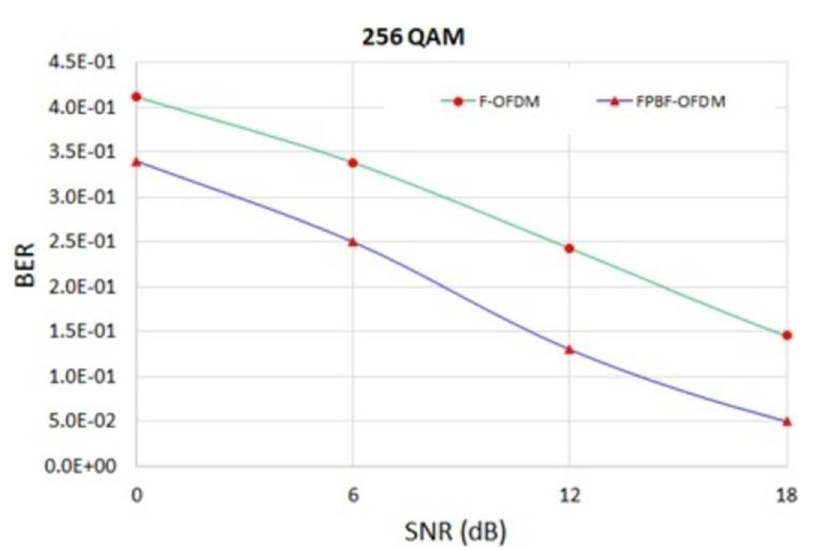
Fig 4. BER of F-OFDM and FPFB-OFDM for different SNR level.